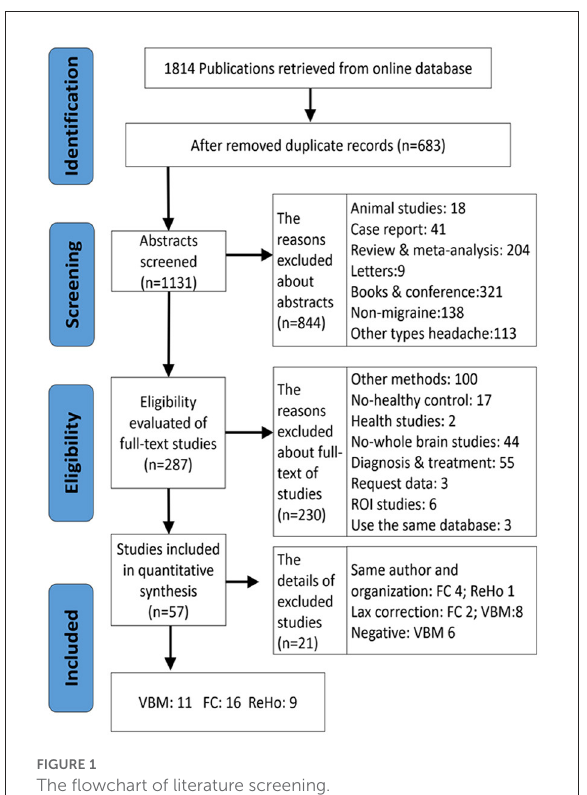
FIGURE1 The flowchart of literature